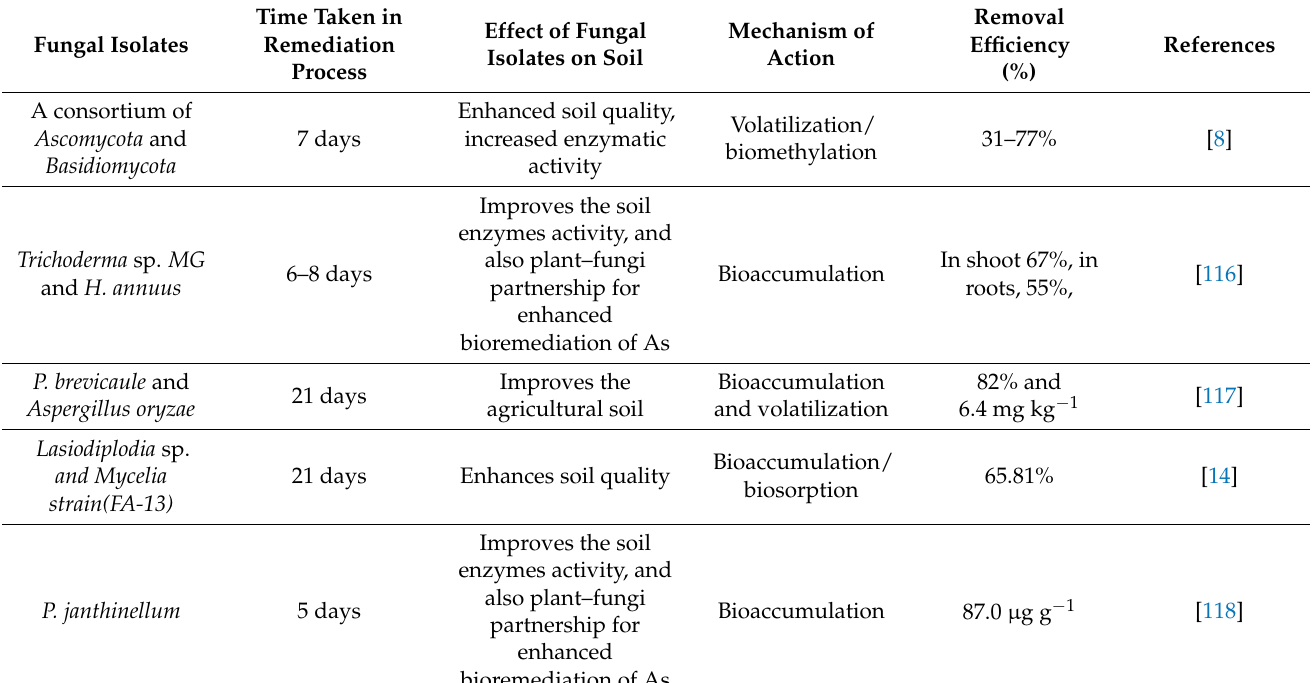
Table 1. Mode of action of fungal isolates in arsenic contaminated